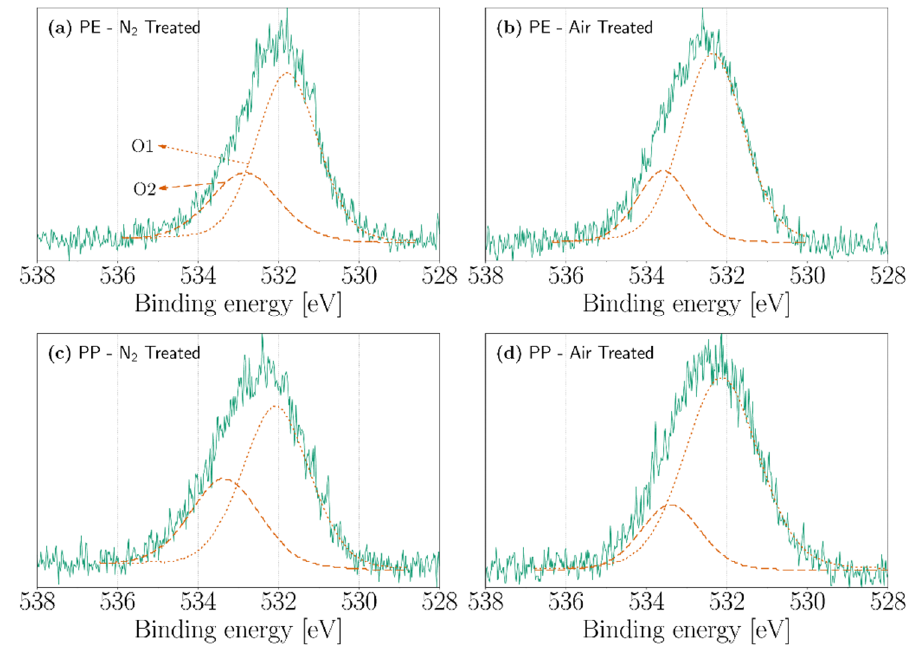
Figure 8. XPS high-resolution oxygen (O1s) spectra of ( a ) nitrogen-treated PE, ( b ) air-treated PE, ( c ) nitrogen-treated PP, and ( d ) air-treated PP.